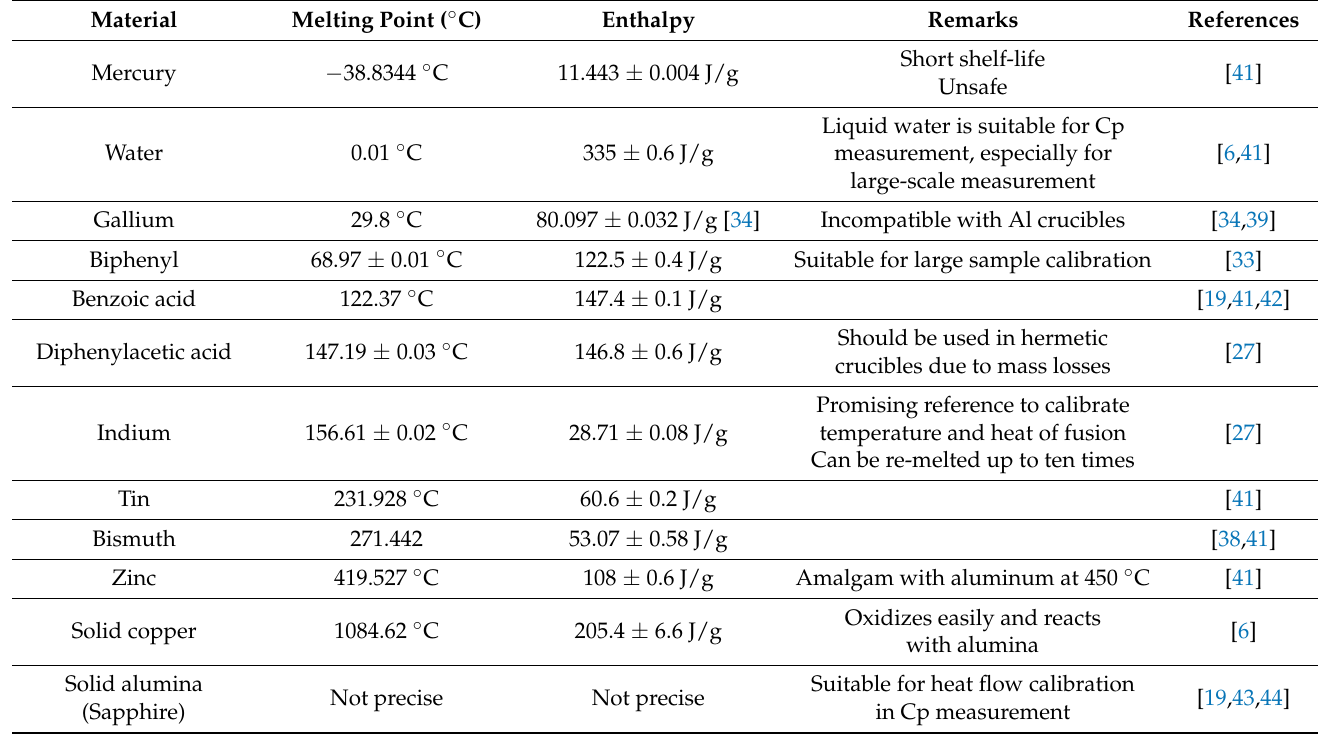
Table 4. Reference materials for DSC